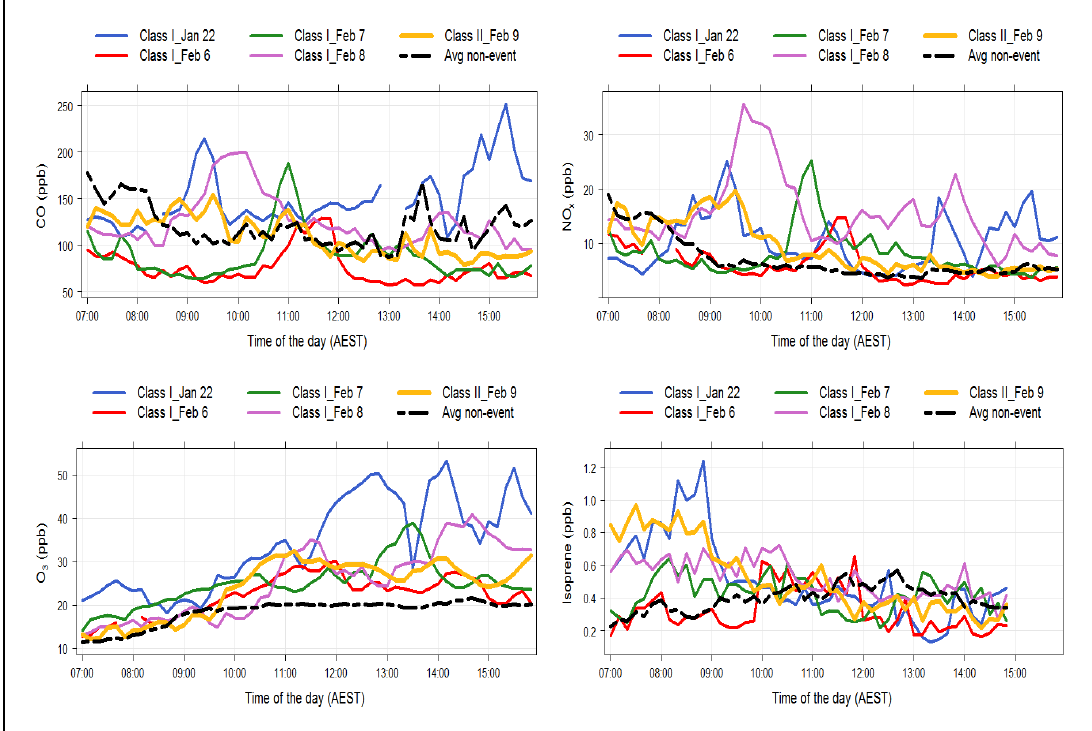
Figure 7. Time series of CO, NO x O 3 and isoprene on Class I event days (22 January, 6 February, 7 February and 8 February 2013), a selected Class II event day (9 February 2013) and on the non-event days. Ten-minute averaged data were used. Only measurements from 7:00–15:00 AEST (+10 UTC) are plotted. The proton transfer reaction mass spectrometry instrument used to measure isoprene was calibrated at